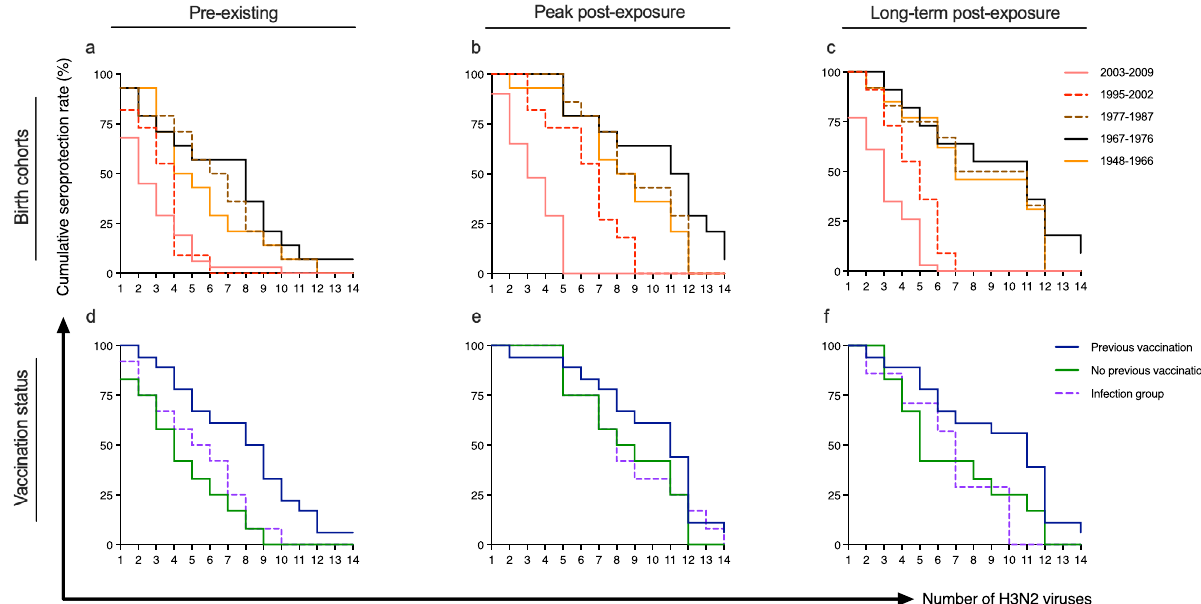
Fig. 7 The impact of priming and previous vaccination on the breadth of hemagglutination inhibition (HI) A/H3N2-speci fi c antibody responses. The cumulative seroprotection rates (cumulative percentages of individuals with HI titres ≥ 40) against a range of in fl uenza A/H3N2 viruses (total 14 viruses) regardless of the viruses ’ circulation time pre-exposure (pre-vaccination or infection) ( n = 84) ( a ), peak responses post- exposure (day 21/28 post-vaccination or 6 months post-infection) ( n = 84) ( b ), and long-term post-exposure (6 months post-vaccination or 18 months post-infection) ( n = 79) ( c ). Subjects were strati fi ed by their birth year based on the likelihood of priming with different in fl uenza A subtypes ( a – c ). Children were divided into two birth cohorts: 2003-2009 and 1995-2002 (both H1/H3 primed) and adults were divided into